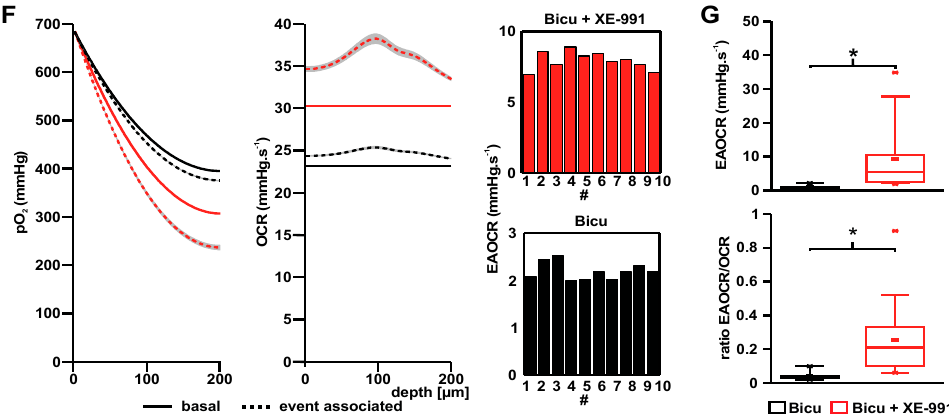
Figure 3. Locality of activity and modeling of local oxygen consumption rates associated with ILEs and SLEs in brain slices: ( A ) Typical f.p., extracellular potassium ([K + ] o ) and oxygen recordings of ILEs ( black ) and SLEs ( red ). Event-associated oxygen baseline drops were larger in SLEs compared with ILEs; ( B ) Local oxygen drops during ILEs and SLEs at 80 μ m from the slice surface. Event-related pO 2 drops during SLEs ( red ) were significantly larger compared with ILEs ( black ) ( p = 0.011, n = 8 and 15 for ILEs and SLEs respectively, independent t -test); ( C ) Scheme of brain slice recordings under interface conditions with two pairs of double-barreled potassium-sensitive microelectrodes and Clark-style oxygen electrodes. One pair of electrodes was moved in vertical steps through the pyramidal layer in area CA3 (moving electrode). A second stationary pair of electrodes was placed in close vicinity at ~80 μ m below the slice surface (fixed electrode) to control for signal stability; ( D ) Overlay of the recording signals from the two pairs of electrodes ( black : moving electrode, grey: fixed electrode) during bicuculline-induced ILEs. F.p., [K + ] o and oxygen drops remained stable at the fixed electrode, while f.p. amplitudes and [K + ] o peaks were larger at 100 μ m compared with 0 and 200 μ m at the moving electrode. Oxygen dips increased from 0 to 100 μ m and remained large at a depth of 200 μ m in the moving electrode; ( E ) ILE-associated amplitudes, event-related peak potassium levels and pO 2 -drops at different depths along the slice. Field potential and potassium levels showed a very similar amplitude distribution with a peak around 100 μ m. Oxygen drops were smaller near the surface, but remained stable after 60–80 μ m ( gray —fixed electrode, black—moving electrode); ( F ) Fitted basal pO 2 -depth profiles ( left , solid line) and event-associated depth profiles ( left , dashed line) for bicuculline ( black ) and bicuculline + XE-991 ( red ). Basal OCRs (solid line, right graph) and depth-dependent event-associated OCRs (EAOCR, dotted line, right graph, EAOCR = OCR/event (mmHg·s − 1 )). Bar plots show EAOCRs for ten individual events; and ( G ) EAOCR ( top ) and ratio of EAOCR to basal OCR ( bottom ) during ILEs and SLEs. During SLEs ( red ) EAOCRs were significantly higher compared with EAOCRs during ILEs (black; p = 0.016, n = 8 and 15 for ILEs and SLEs; independent t -test). The ratio comparing EAOCRs to the basal OCR was significantly higher under SLEs compared with ILEs ( p = 0.035, n = 8 and 15 for ILEs and SLEs, respectively, independent t -test).